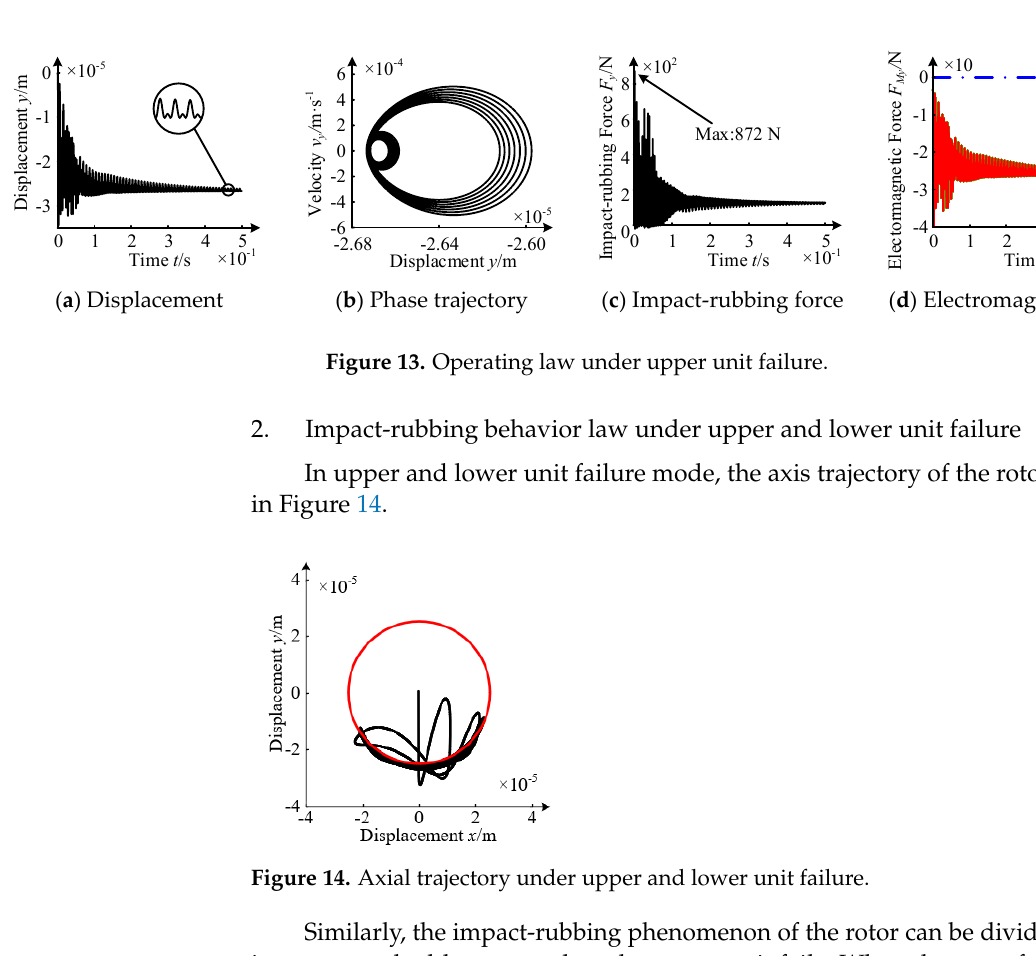
netic force were extracted, as shown in Figure 13.